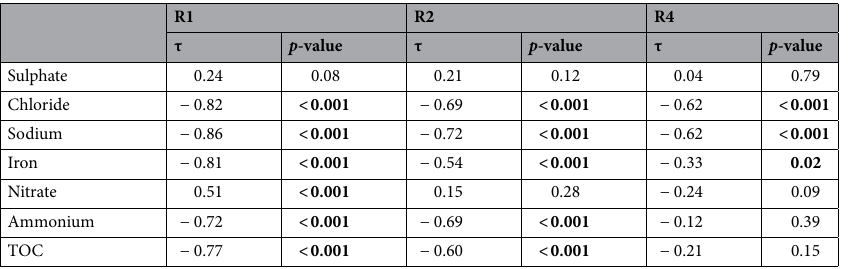
Table 1. Mann–Kendall trend test results for parameters measured from 1992 to 2019. Significant results ( p < 0.05) are indicated in bold face. R1, R2 and R4 are the monitoring wells located along the groundwater flow path in an increasing distance from the edge of the landfill. τ is the Kendall’s test statistic.